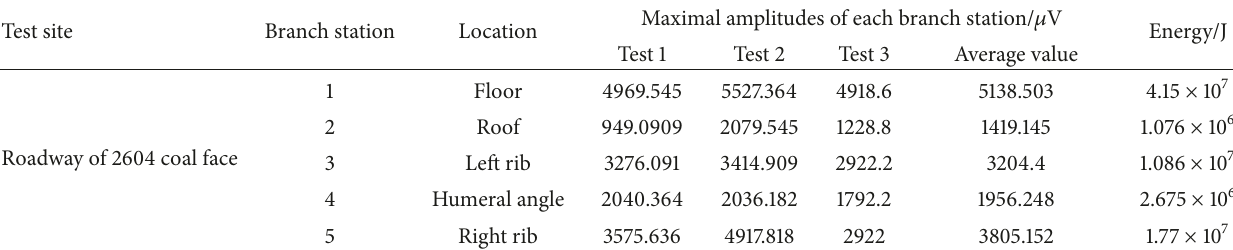
Table 3: Calculated peak amplitudes and seismic energies received at each branch station.